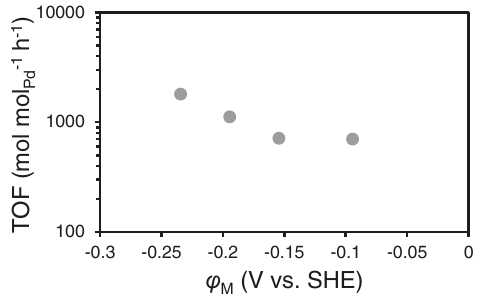
Fig.6|TOFasafunctionofelectricpotentialofPdatpH1.6. Reactioncondition: 10mgPd/C (5wt.%) at